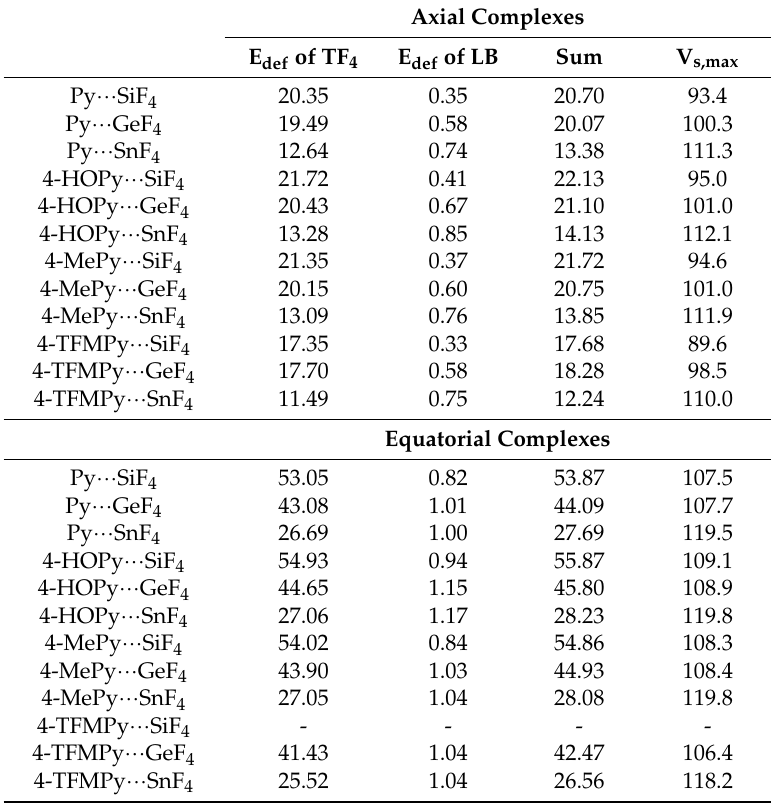
Table 6. Deformation energies of complexes and maximum of MEP for TF 4 in its geometry within the complex, calculated at the MP2/cc-pVTZ (I) level of theory. All quantities in kcal/mol. Axial